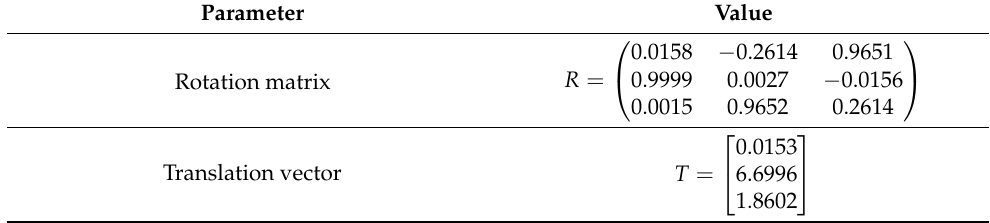
Figure 12. Detecting checkerboard corners.